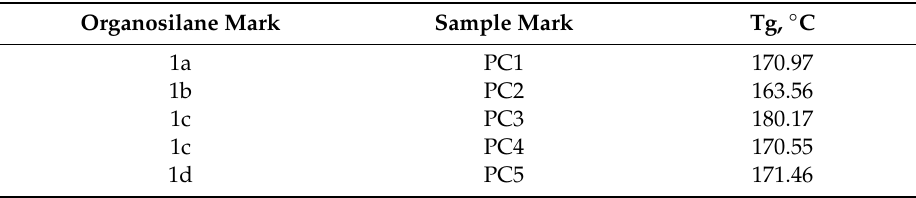
Table 3. Glass transition temperatures, depending on applied organosilane.